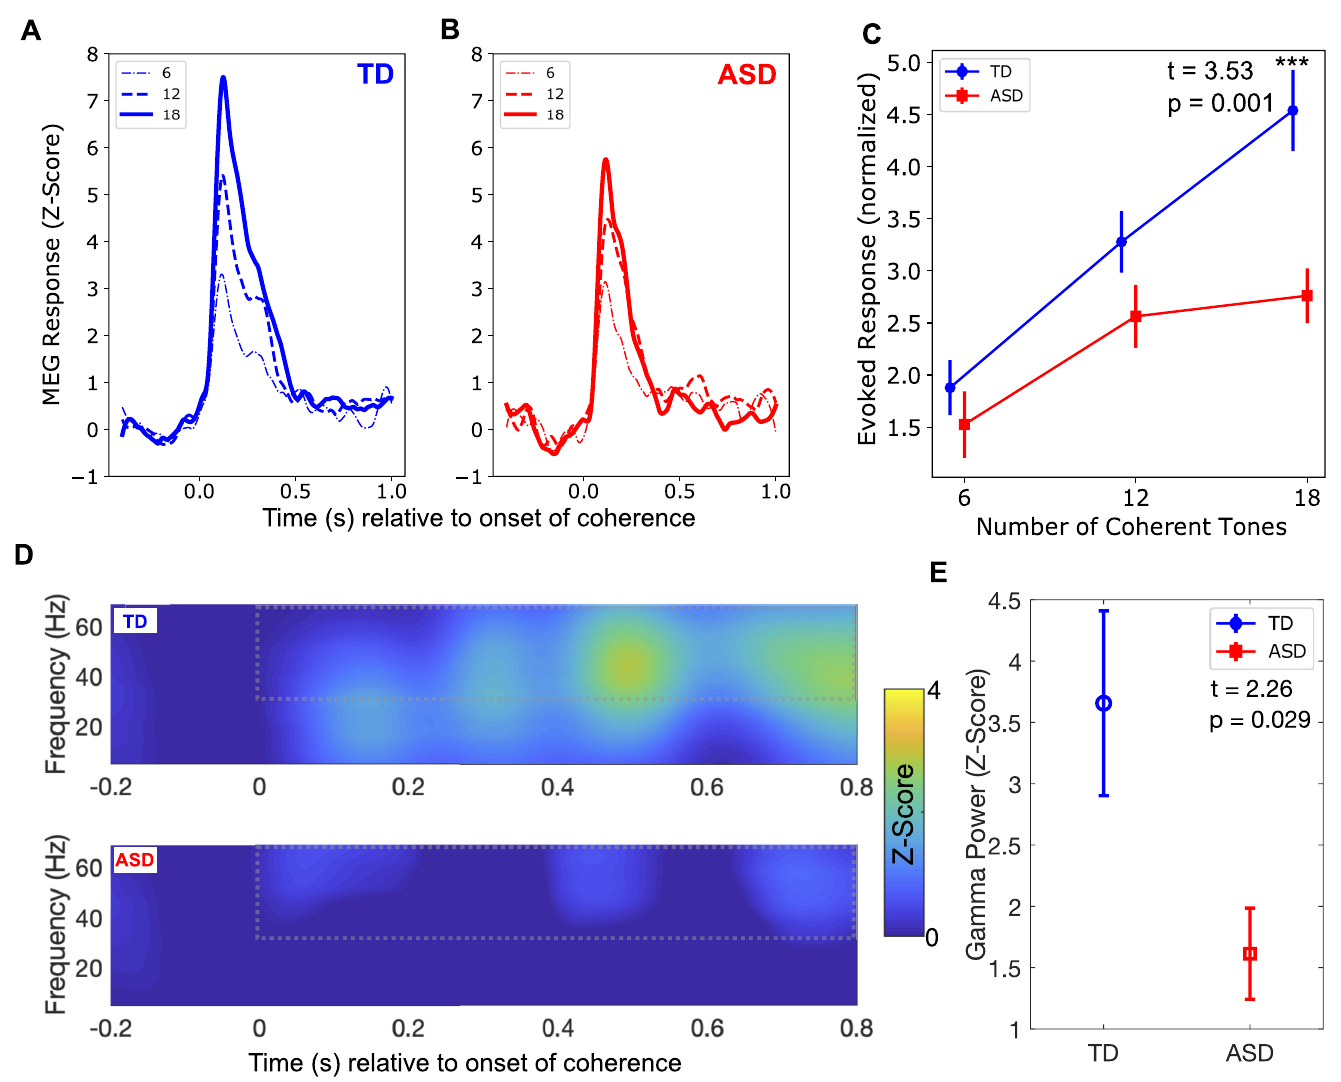
Fig 3. Evoked and induced responses following changes in temporal coherence. (A) Evoked responses in the typically developing (TD) group, where time = 0 represents the onset of a 1-s coherently modulated period within the trial (white arrows in Fig 1B), not the onset of the trial. The responses are plotted for each of the 3 coherent-modulation conditions ( N = 6, 12, and 18), each averaged separately. (B) Same as (A), for the autism spectrum disorder (ASD) group. (C) Averaged amplitude of the responses in (A) and (B), over the 50-ms to 450-ms time window, for each condition and group. ��� The group difference was significant at the N = 18 condition. (D) Time-frequency plot for the TD group (top) and ASD group (bottom) in response to the N = 18 condition, where time = 0 represents the onset of the 1-s coherently modulated period within the trial (white arrows in Fig 1B), not the onset of the trial. Dotted line outlines the time-frequency window used to compare the two groups. (E) Group difference within the time-frequency window outlined in (D). For both the evoked response and the induced response analysis, the magnetoencephalography (MEG) data during the incoherent stimulus portion that preceded the onset of the coherent figure was used as the baseline. Underlying data can be found on Zenodo (doi: